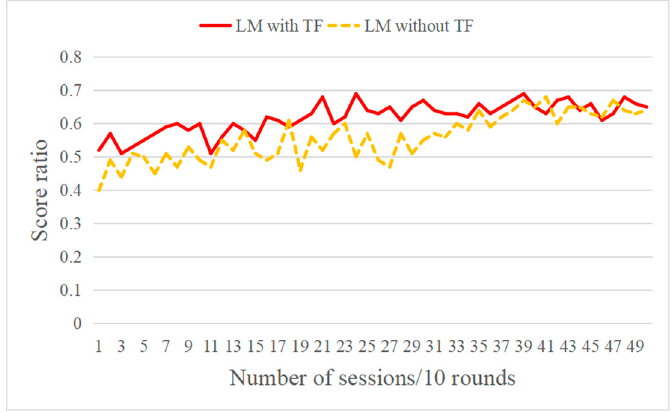
Figure 17. Comparisons of learning models in the defensive score. ( a ) The defensive score for LM with TF and TD_team; ( b ) Defensive score for LM without TF and TD_team.